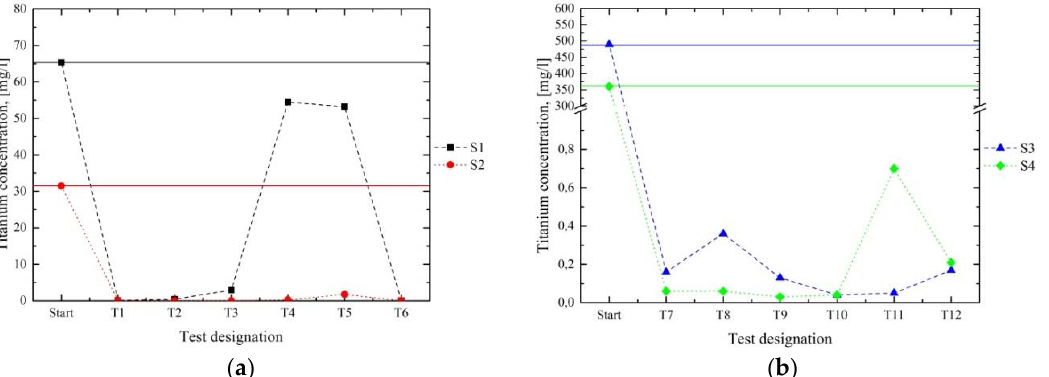
Figure 9. Concentration of titanium in the initial solutions (start, continuous line) and in the filtrates of series 1 ( a , T1 – T6) and series 2 ( b , T7 – T12) [3].